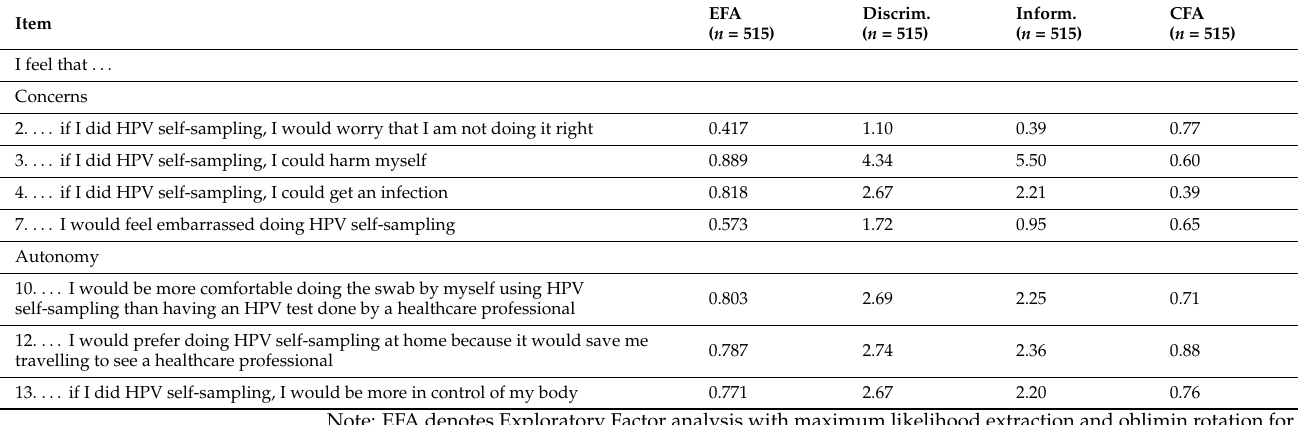
Table 5. Results of factor (EFA; CFA) and IRT analyses for the final items of the HPV Self-Sampling Attitudes and Beliefs Scale items (7 items).